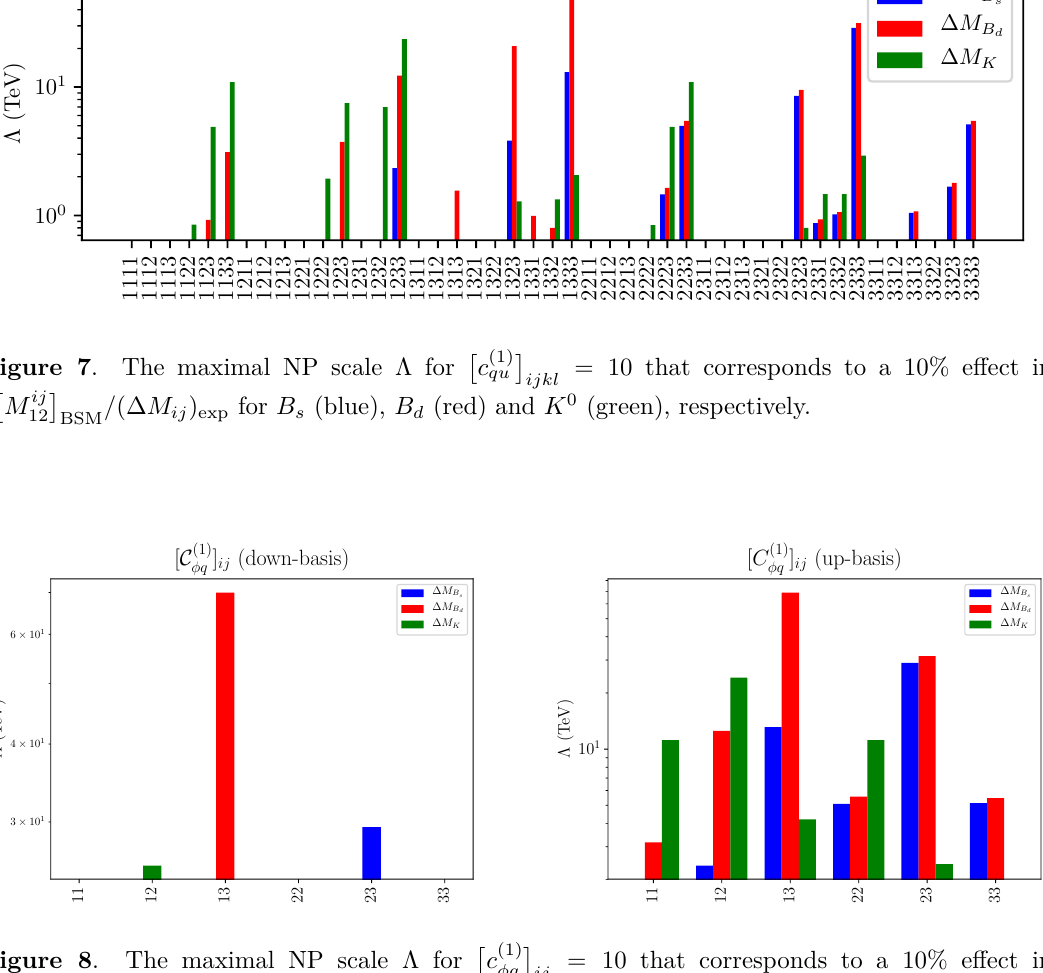
Figure 8 . The maximal NP scale Λ for (cid:2) (cid:3) M ij / (∆ M ij ) exp for B s (blue), B d (red) and K 0 (green), 2 12 BSM